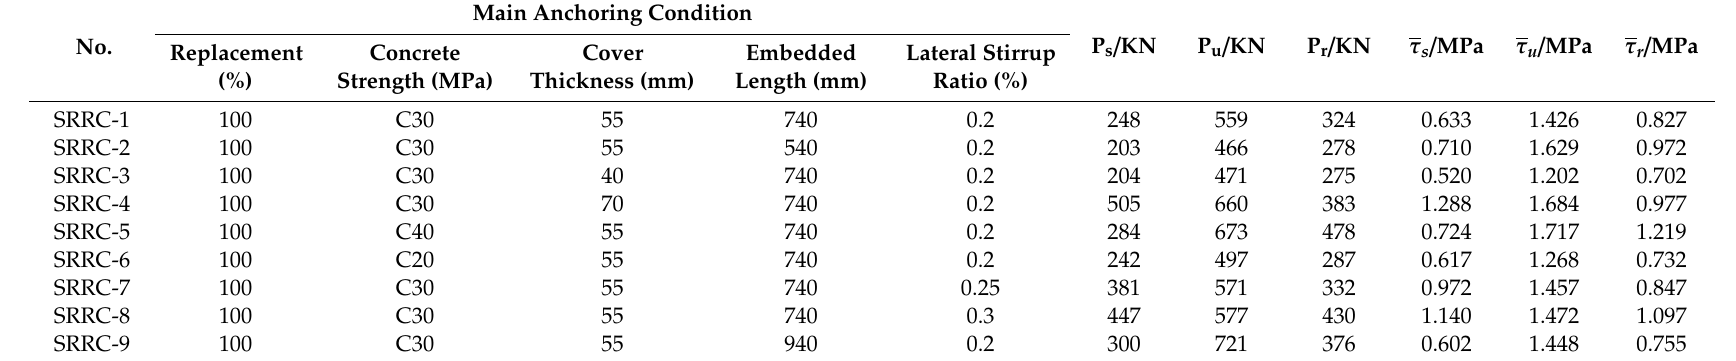
Table 5. Results of characteristic load and bond stress tests.